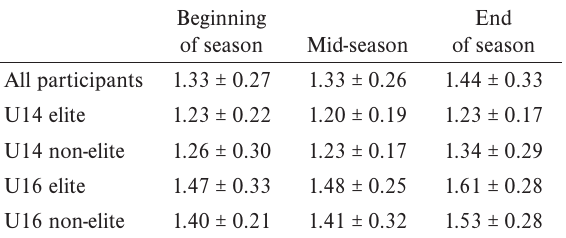
Mean ± SD of reactive strength index (in mm/ms)